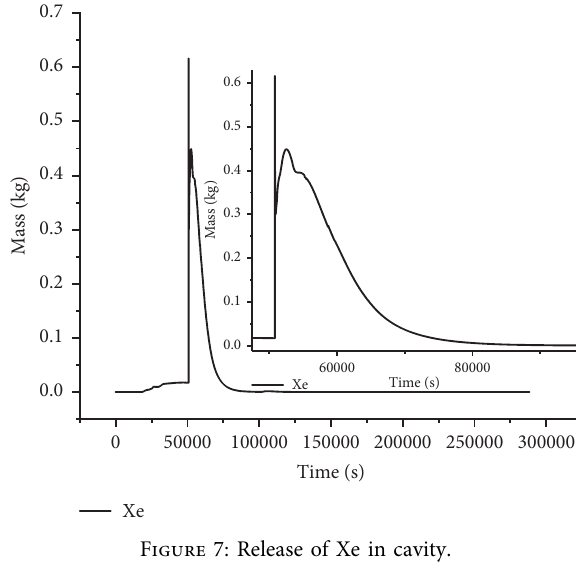
Figure 7: Release of Xe in cavity.